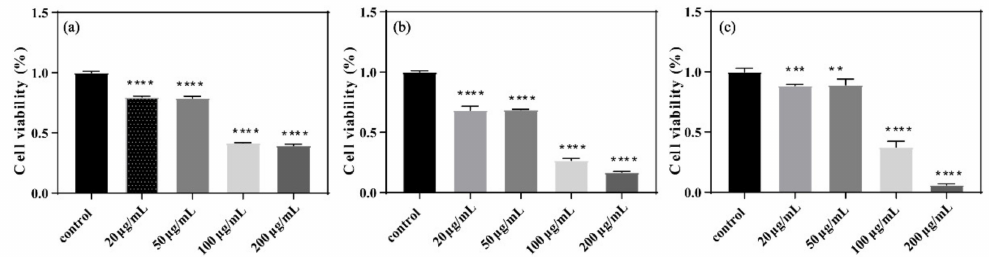
Figure 3. Survival rates of E. coli exposed to GORs in different concentrations at 24 h ( a ), 48 h ( b ), and 72 h ( c ) (** p < 0.01, *** p < 0.001 and **** p <